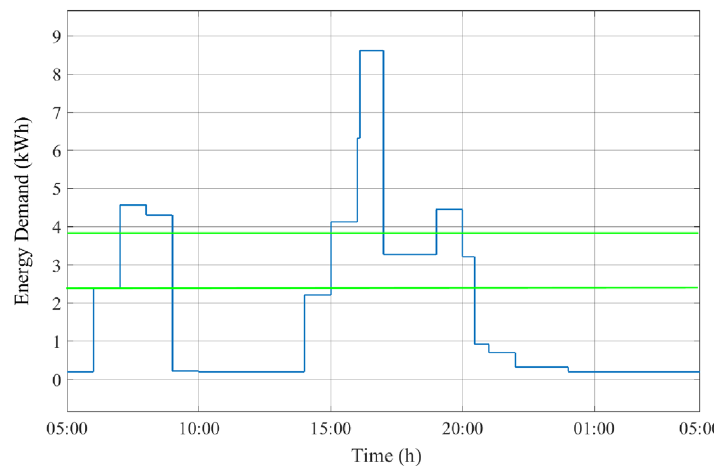
Fig. 6 Energy demand profile (average limits in green